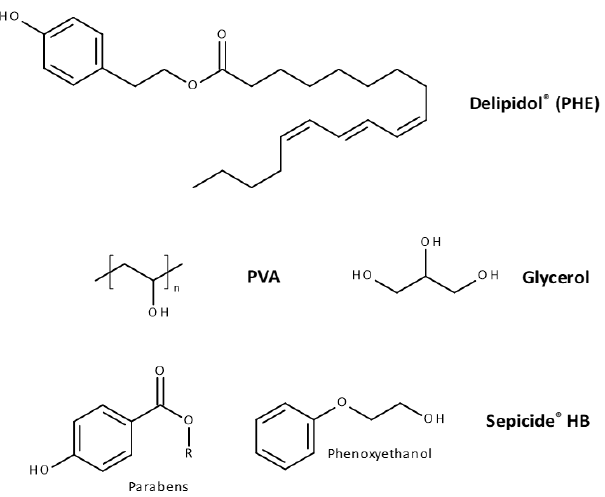
Figure 1. Main components for the preparation of PVA-GS films.